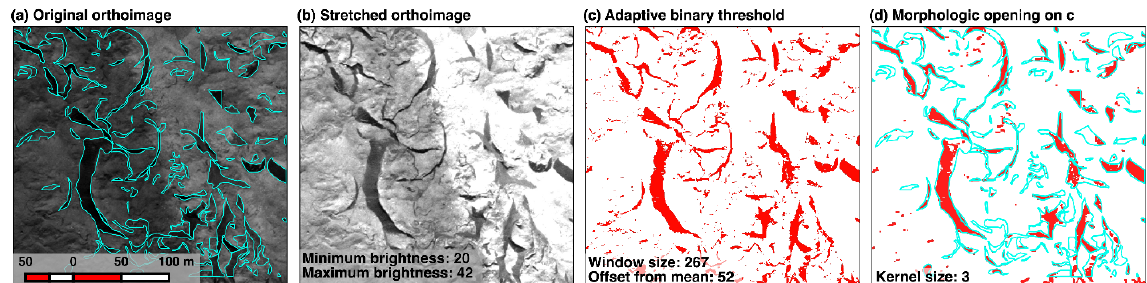
Figure 8. Ice cliff delineation workflow for the adaptive binary threshold (ABT) method. The extent of this area is shown by the third cyan box from the right in Fig. 9. (a) Original orthoimage with manually digitized ice cliffs shown in cyan. (b) Orthoimage after histogram stretch using a set of well-performing brightness values from the parameter optimization. (c) ABT on stretched orthoimage. (d) Morphologic opening on adaptive binary threshold to remove small isolated false positive ice cliff delineations. Manually digitized ice cliffs used as the validation dataset are again shown in cyan.